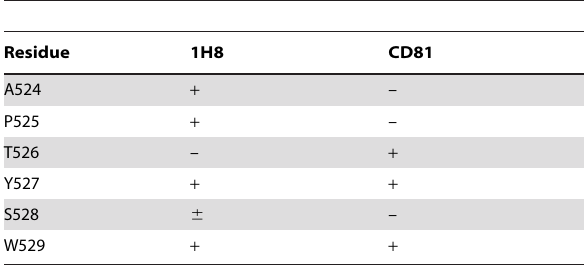
Table 2. Amino acids linked to antibody or CD81